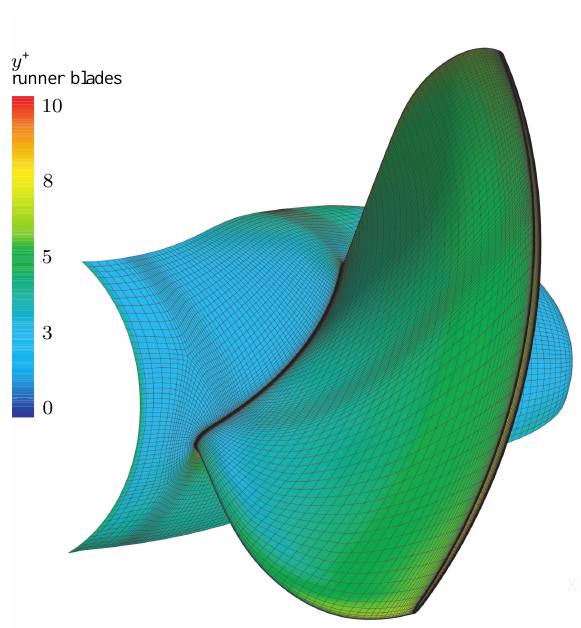
Fig. 4. Mesh of the runner with y + -v alues on the blade and hub